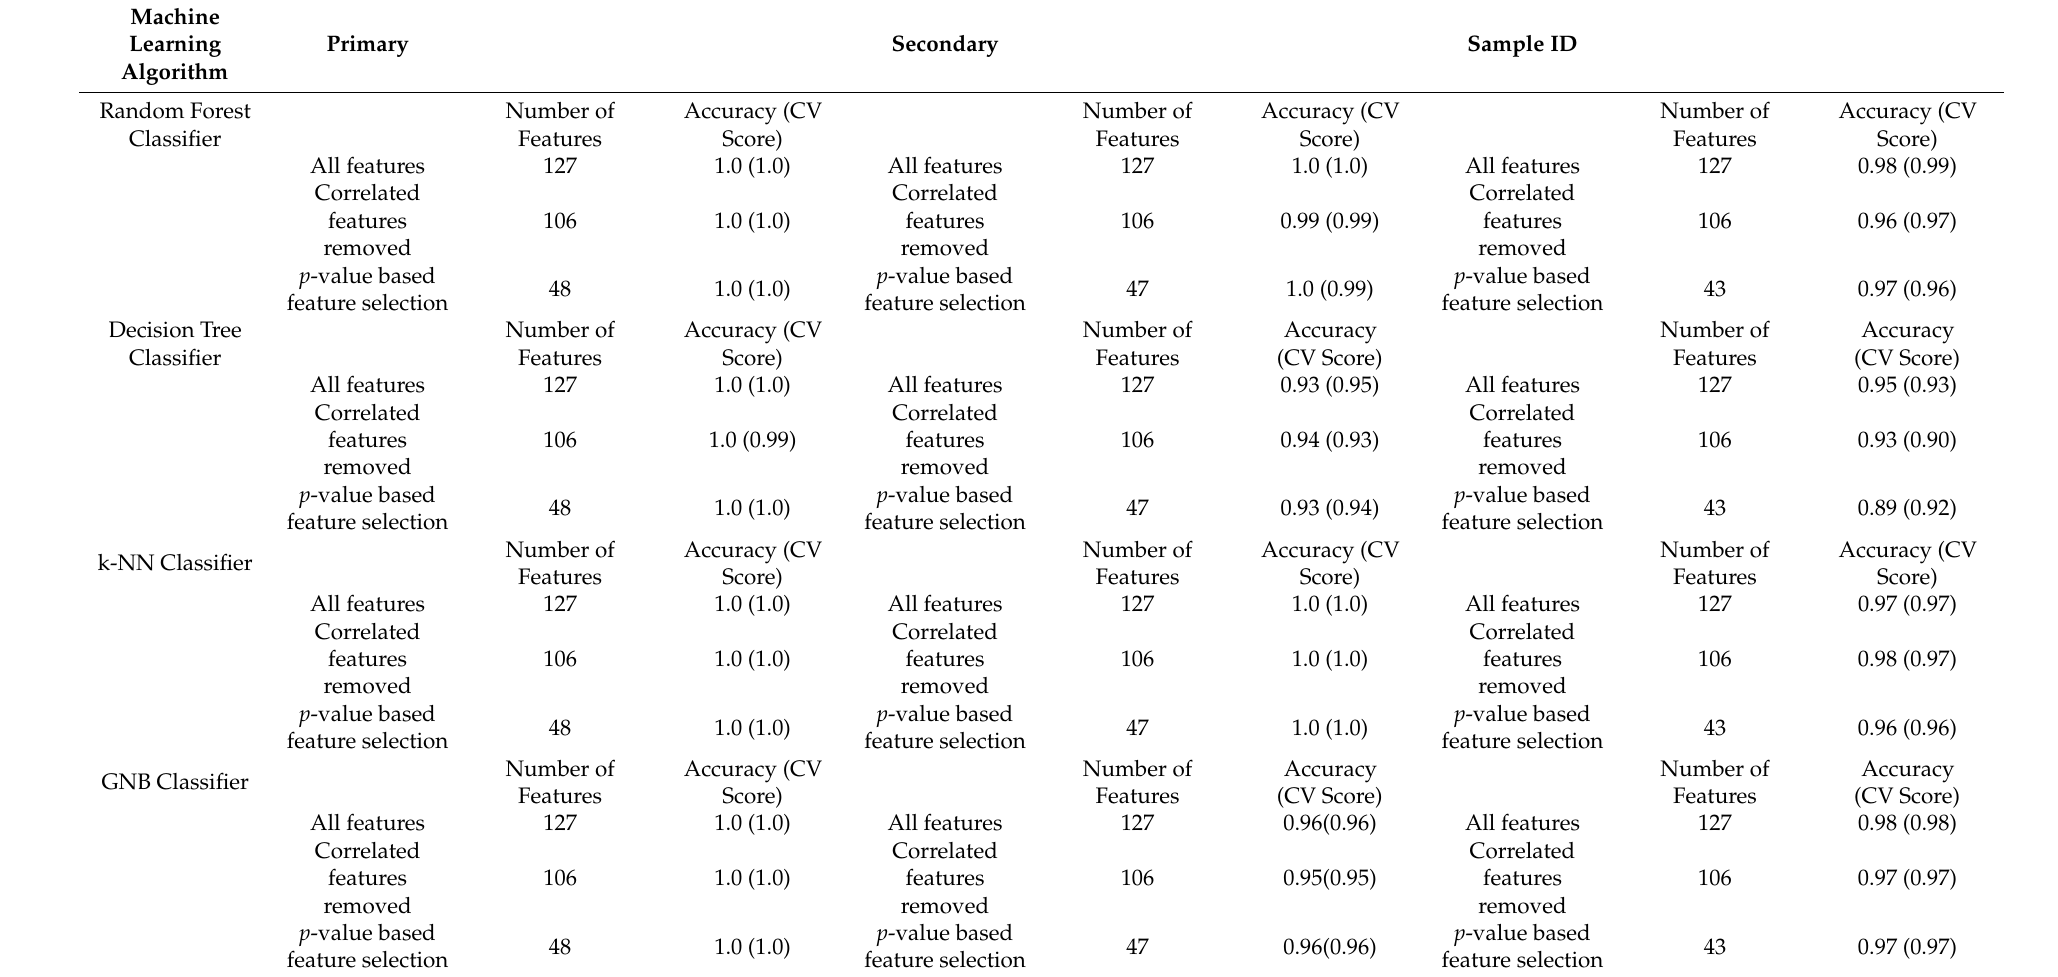
Table 2. Comparison of machine learning (ML) algorithms for prediction of primary type, secondary type, and Sample ID from py-MBMS spectral intensities prior to removal of instrumental variance (RUV)